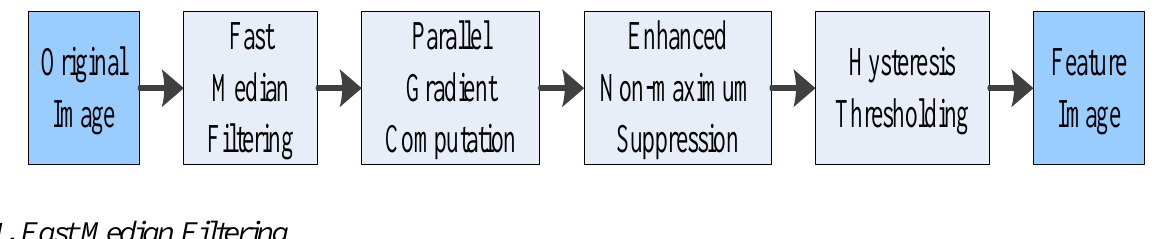
Figure 3. Flow chart of resource-optimized canny edge detection